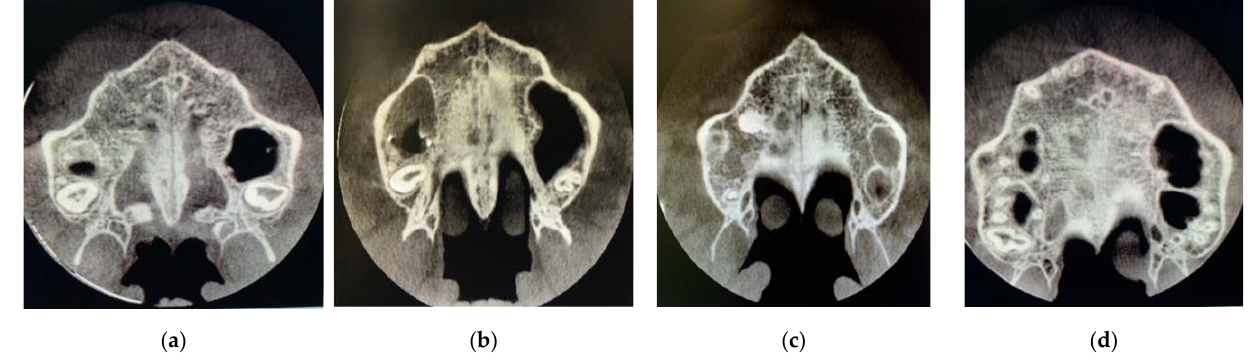
Figure 3. Axial slices of the different stages of the suture in the study. Stage B ( a ), stage C ( b ), stage D ( c ) and stage E ( d ).